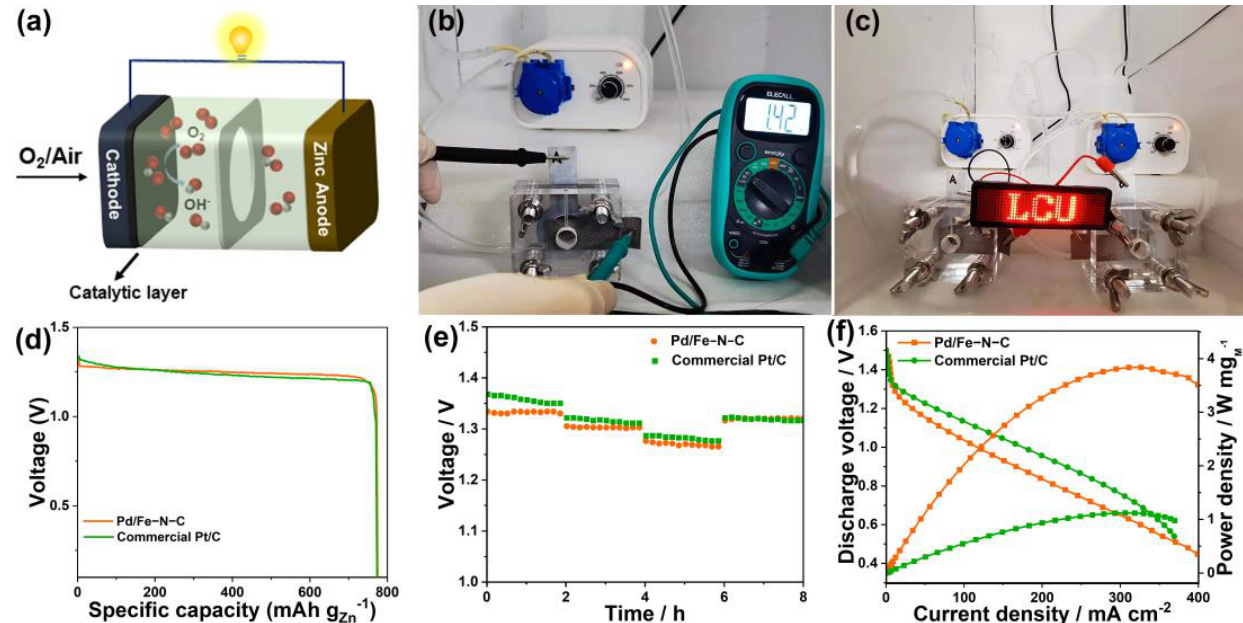
Figure 5. ( a ) Schematic setup diagram of the Zn – air battery. ( b ) OCV measurement for the Pd/Fe-N-C-based zinc – air battery. ( c ) LED board lighted by two Pd/Fe-N-C – based Zn – air batteries. ( d ) Specific capacities of the Pd/Fe-N-C- and Pt/C-based Zn – air batteries at a current density of 10 mA cm − 2 . ( e ) Comparison of the rate capabilities at current densities of 2, 5 and 10 mA cm − 2 . ( f ) Discharge polarization curves and power density plots of the Pd/Fe-N-C- and Pt/C-based zinc – air batteries.